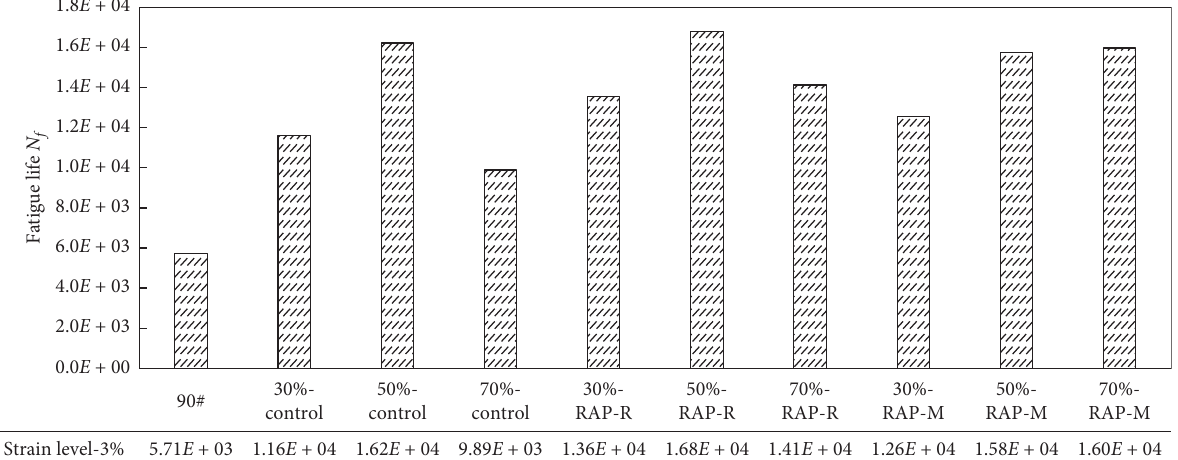
Figure 29: N f at applied strain level of 3% for various asphalt binders.